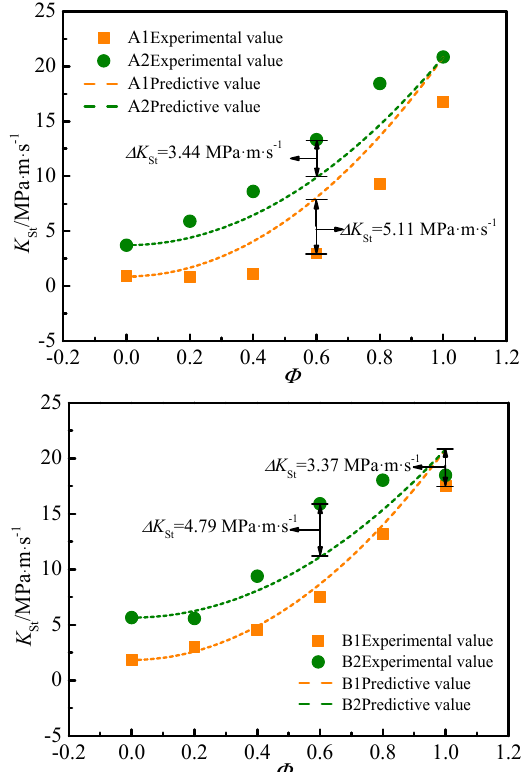
Figure 9. Comparison diagram of explosion index prediction model and experimental results for hybrid mixtures.